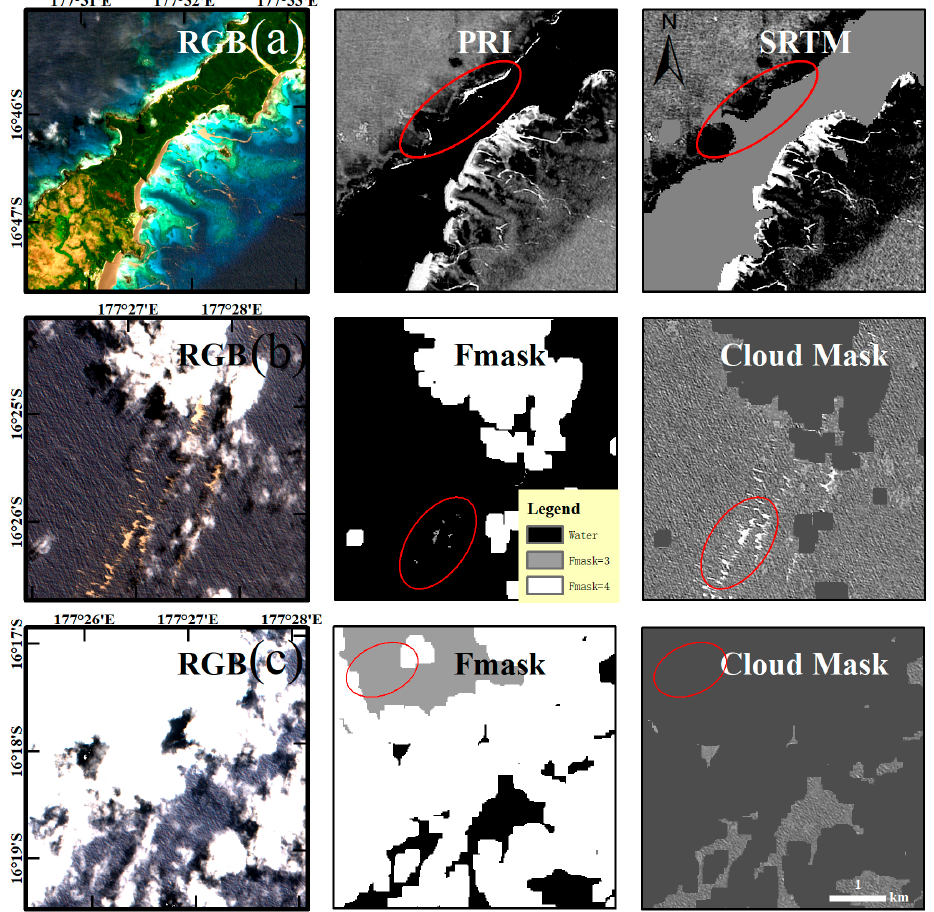
Figure 3. ( a ) The beach shoreline pixels displayed a high value in the PRI image (marked in red ellipse), which were mostly removed after SRTM land masking. ( b ) Pumice and ( c ) thick cloud pixels are mis-identified as snow (Fmask = 3). Cloud pixels were successfully excluded using Fmask = 4 and additional justifications described in Section 3.2. Cloud and land pixels were masked in grey color in the third column.